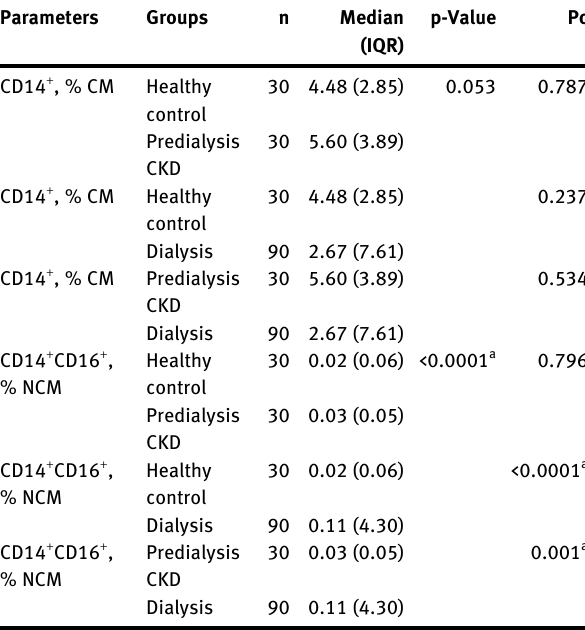
Table  : TLR  expression rates on classical and non-classical monocytes.